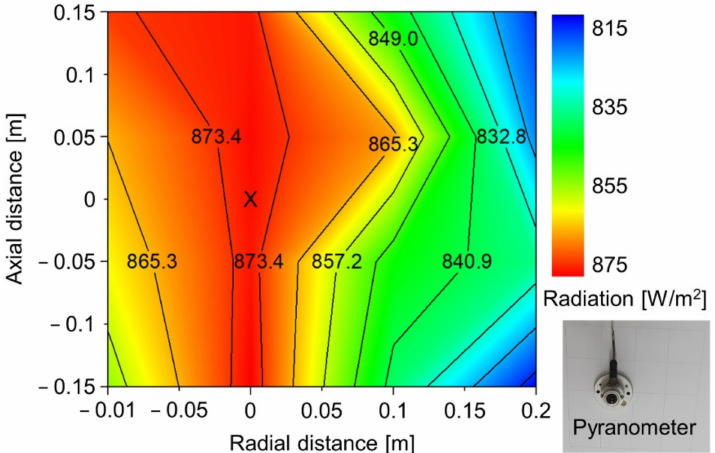
Figure 4. Thermal radiation colormap on halogen lamps and photograph of pyranometer. The marked × represents the center position of the lamps